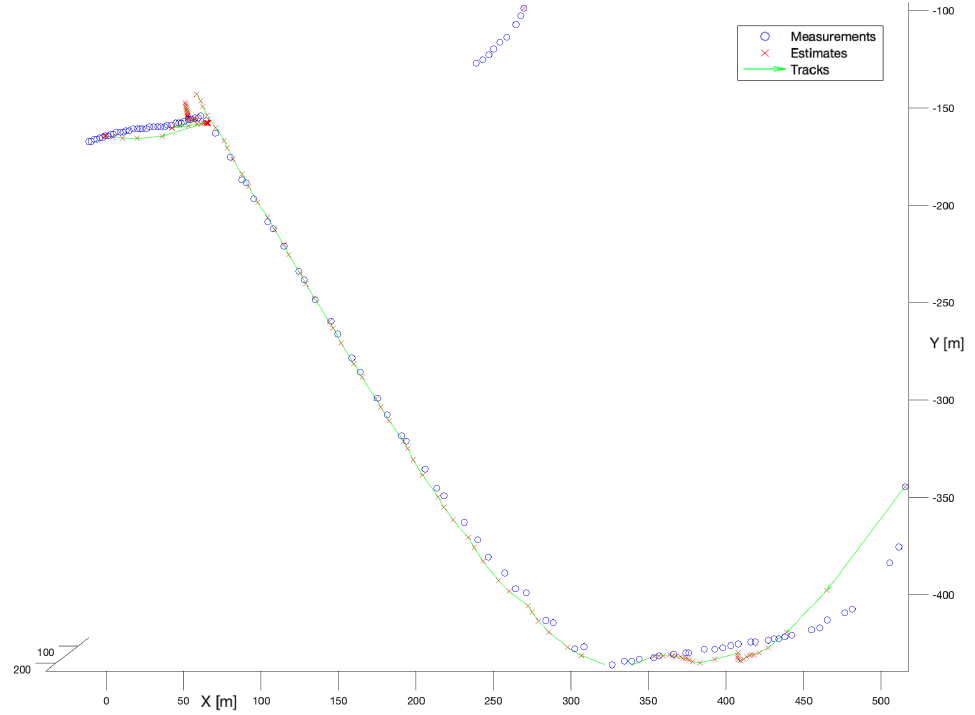
Figure 12. Interacting Multiple Model + Nearest-Neighbour. Multiple bird flight